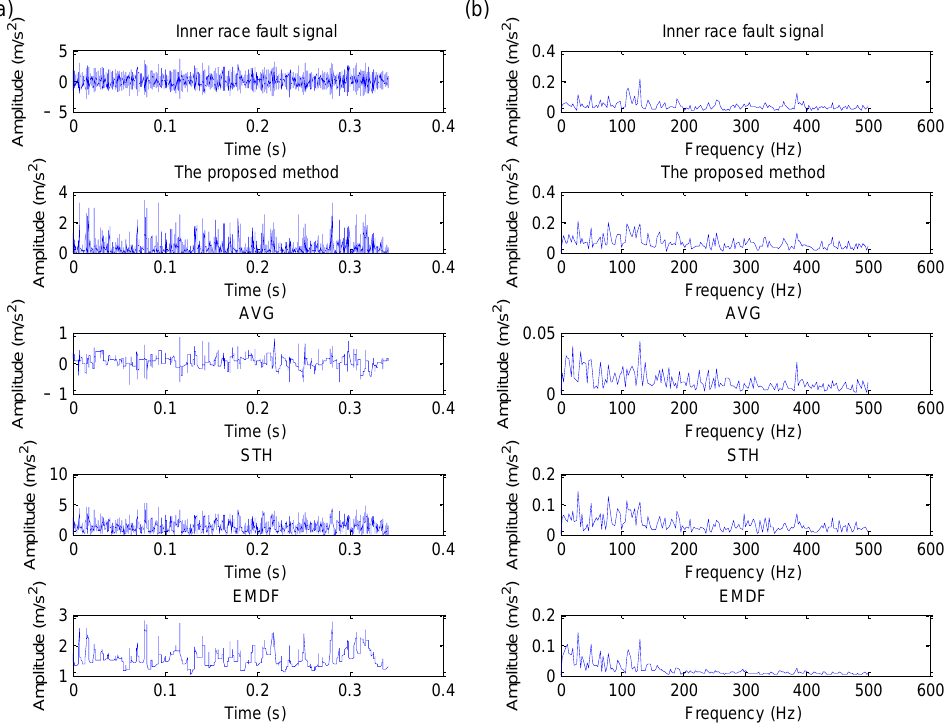
Figure 19. Analysis results obtained by different methods for dataset 170 in case 2: ( a ) Time domain waveform; ( b ) its corresponding envelope spectrum.